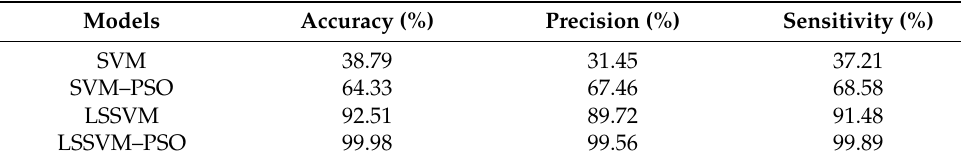
Table 3. The predictive performance of four classification